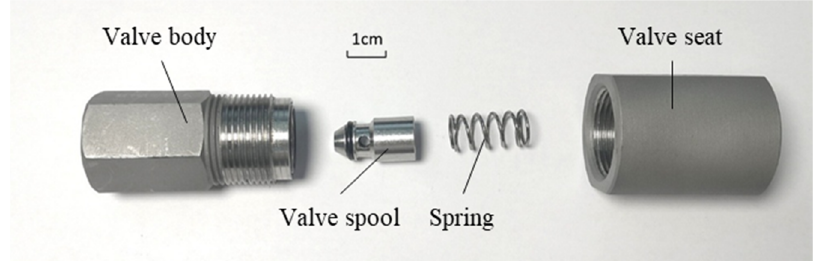
Figure 1. The components of the check valve.